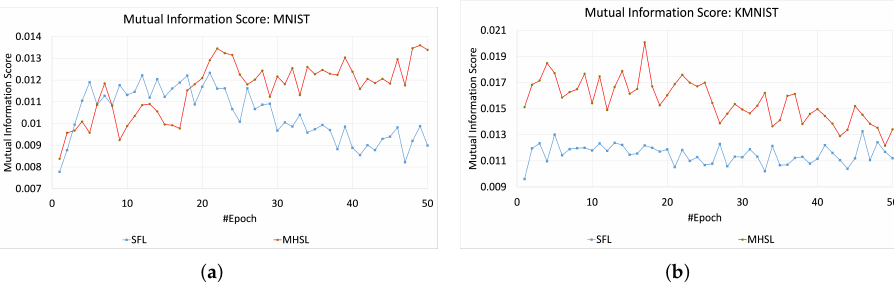
Figure 5. Mutual information score across the epochs for SFL and MHSL for one-channel datasets ( a ) MNIST and ( b ) KMNIST.